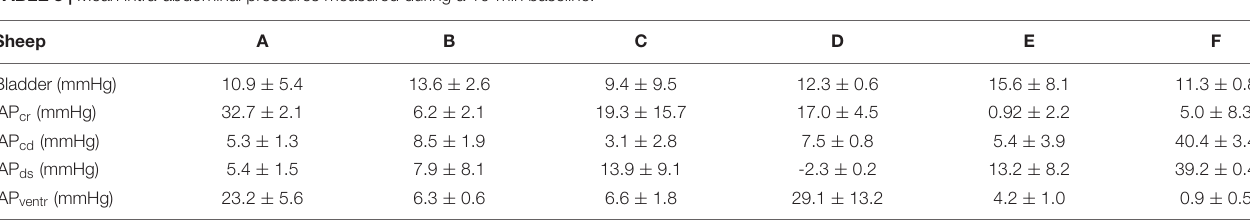
TABLE 3 | Mean intra-abdominal pressures measured during a 10-min baseline. Sheep A B